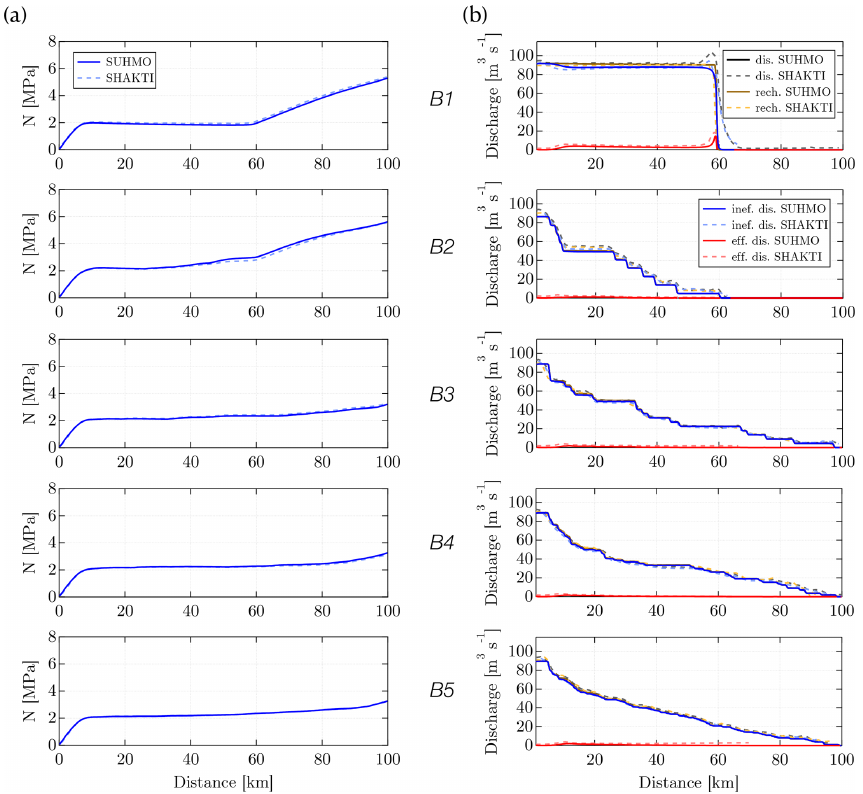
Figure 6. Steady-state results for the SHMIP suite of test cases B: (a) y -average evolution of effective pressure N with distance from the outlet and (b) volumetric discharge, to be compared to the total recharge the system receives (see text for further explanation). The contributions from the inefficient and efficient systems (their sum gives the total discharge) are also featured. For comparison, results from SHAKTI (Sommers et al., 2018) as presented in de Fleurian et al. (2018) are also